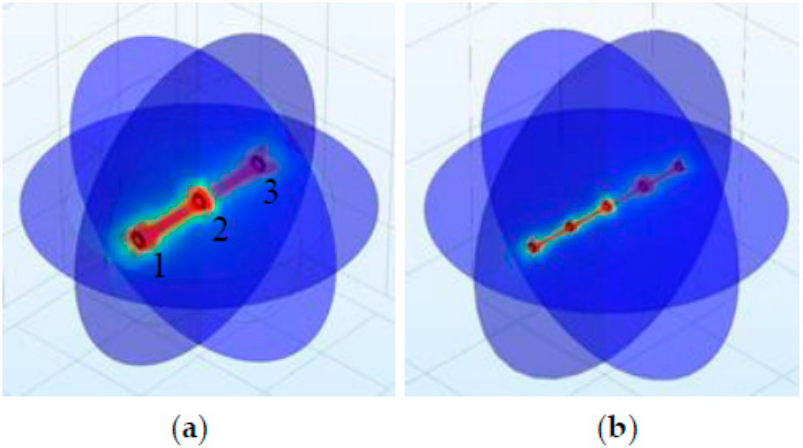
Figure 6. Electromagnetic field distribution of chained systems with ( a ) two loads and ( b ) four loads.